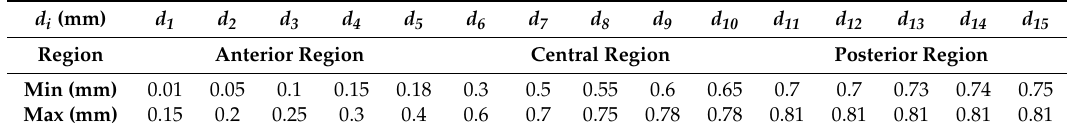
Table 3. Height variable d i before and after optimization.